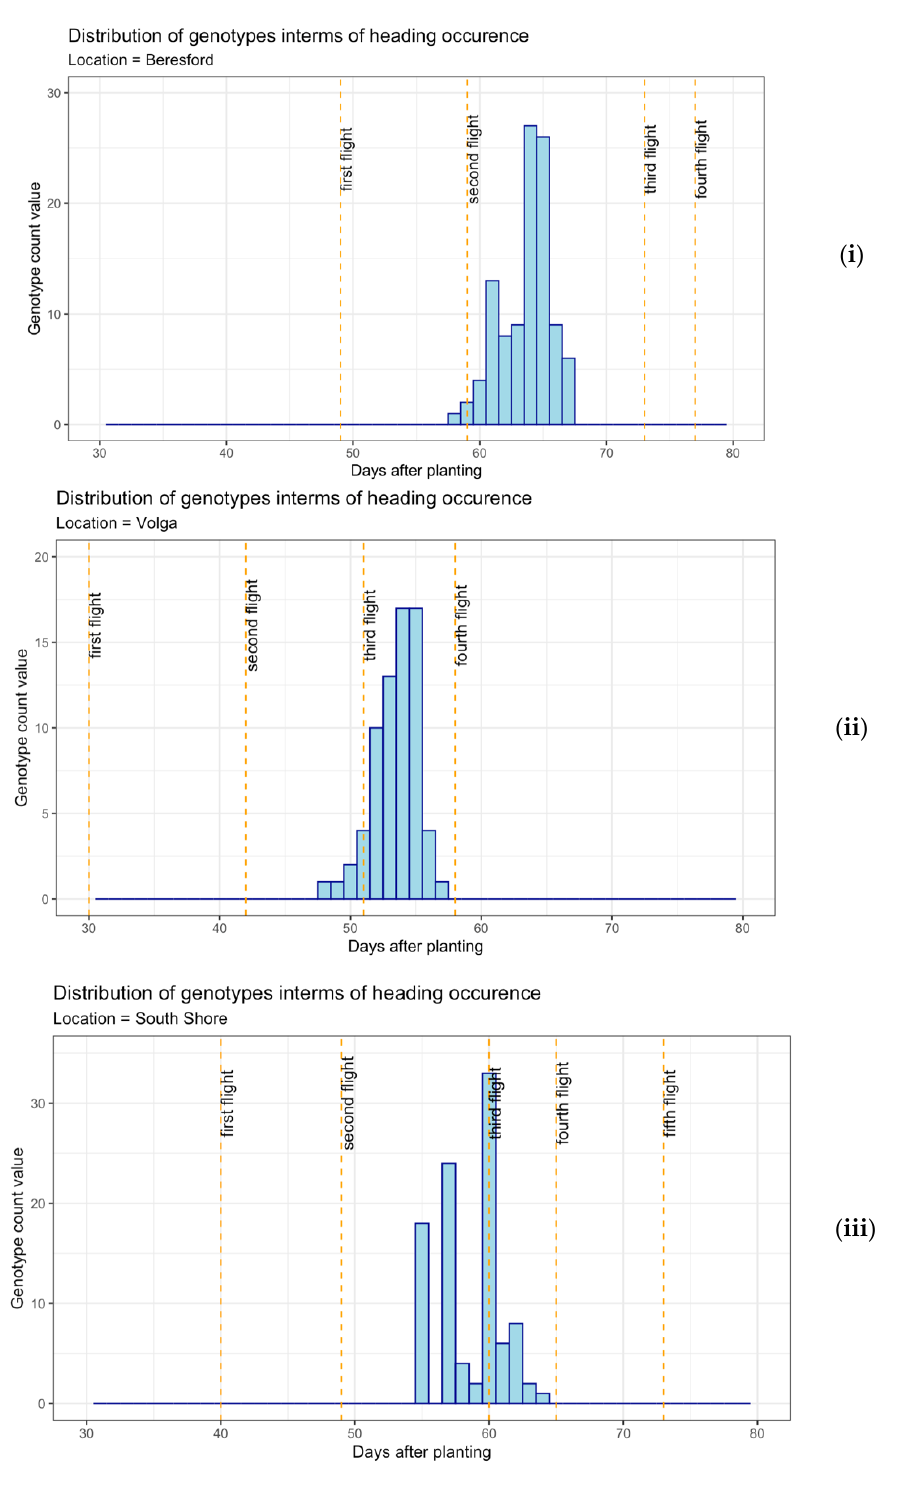
Figure 4. Distribution of heading dates for 35 oats genotypes at Beresford ( i ), Volga ( ii ), and South Shore ( iii ).